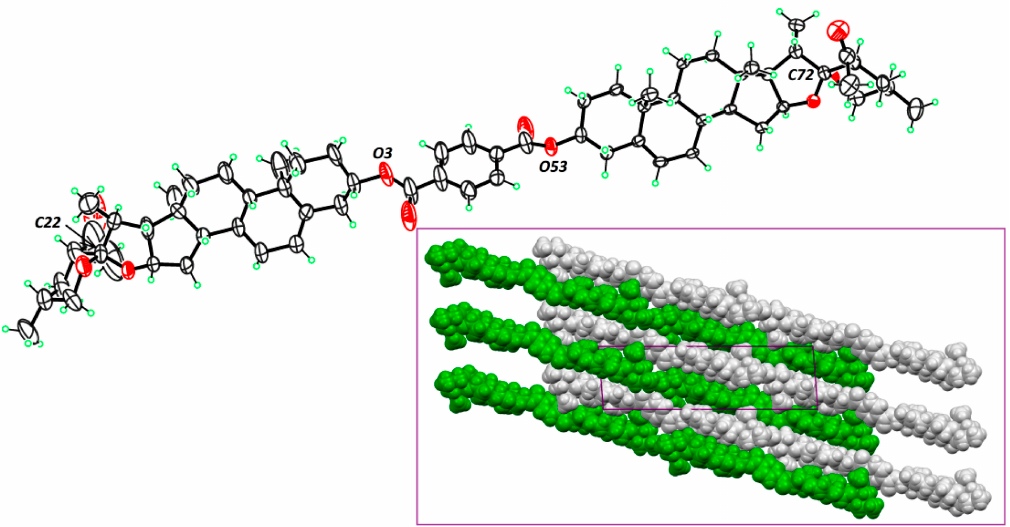
Figure 6. Molecular structure of the bisteroid derivative 10a , with displacement ellipsoids at the 20% probability level. The inset shows a part of the crystal structure, viewed down crystallographic b axis, using a spacefill representation. Grey molecules are generated from the asymmetric unit by lattice translations, while green molecules are generated by the 2 1 -screw axis in space group P 2 1 .